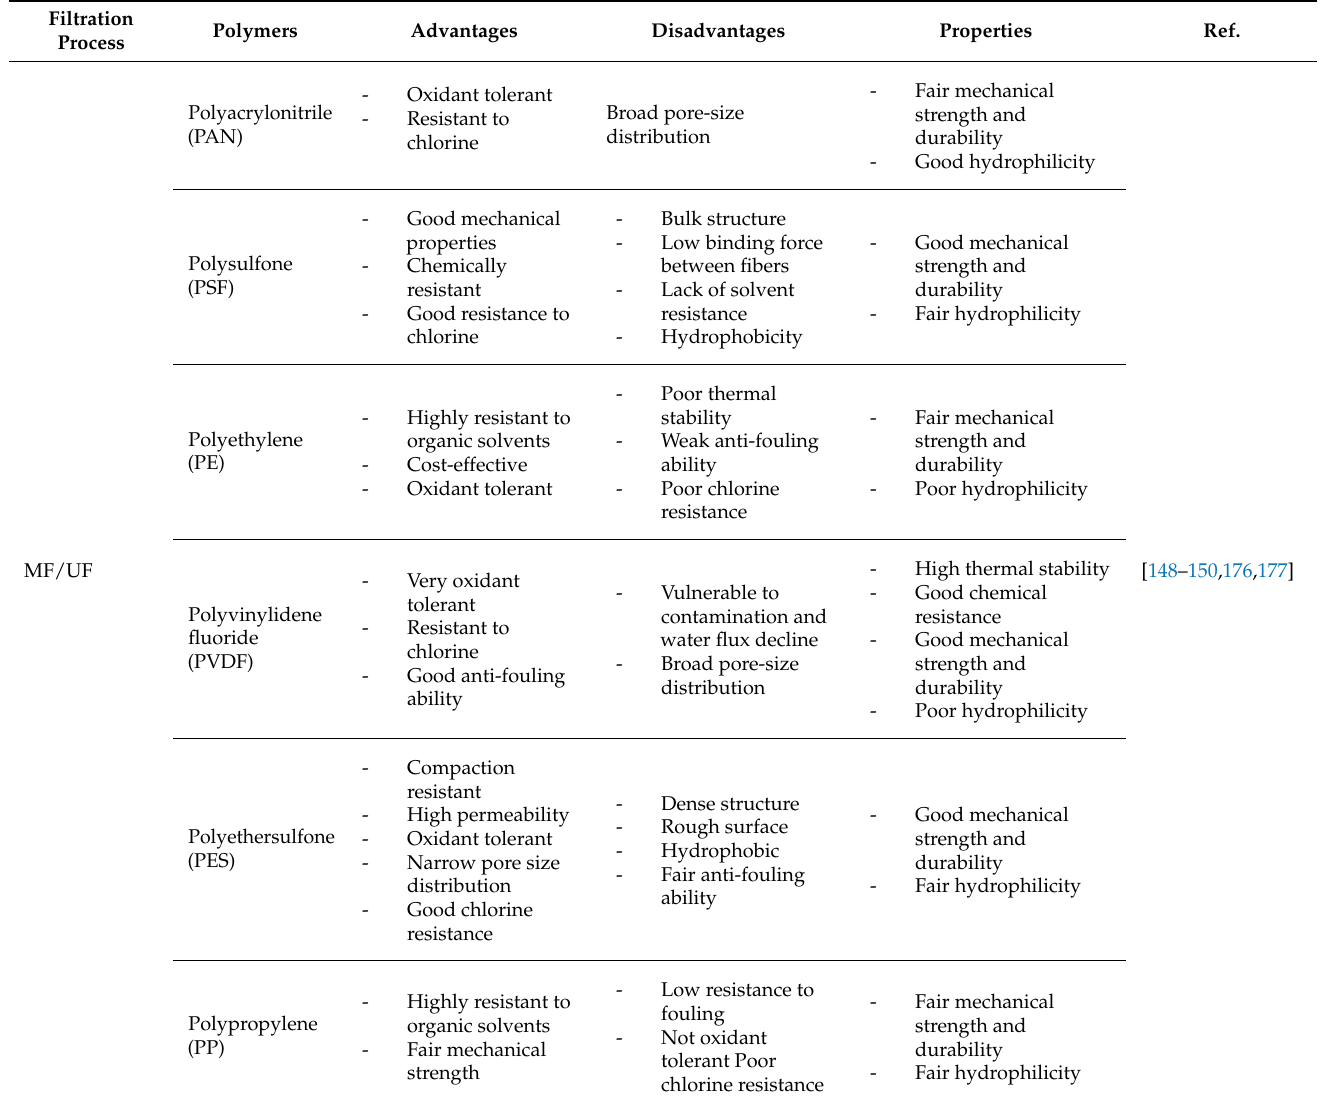
Table 7. Advantages, disadvantages, and features of commonly used polymers for MF, UF, and NF membrane